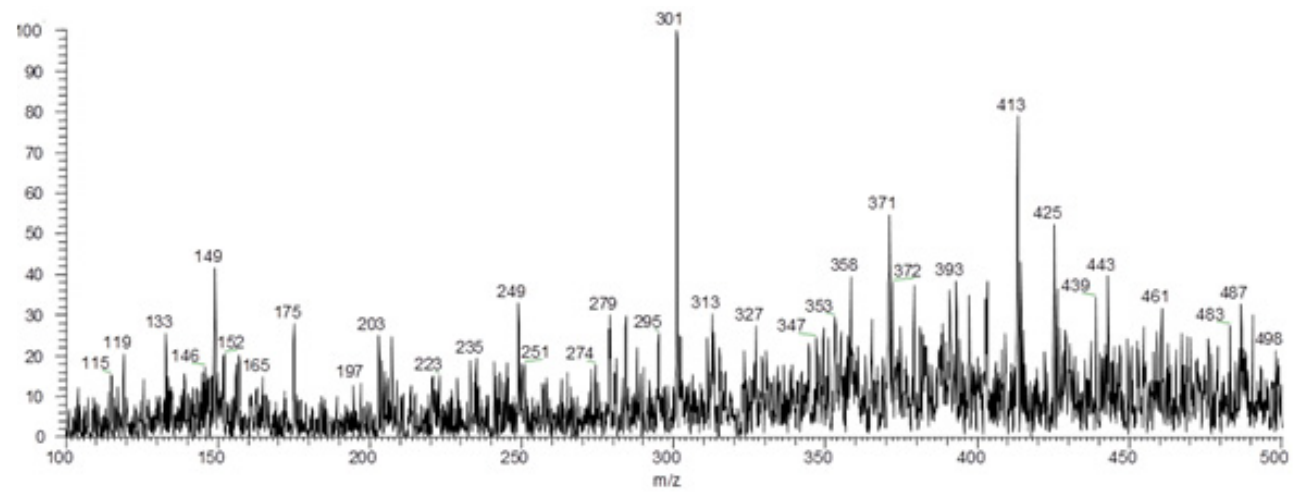
Figure 4. PS (+) MS full scan of ethanol extract from seed of avocado. Table 6. Compounds tentatively identified in avocado seed and peel by (+) PSMS. m /